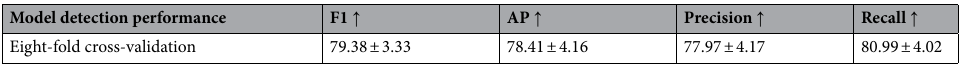
Table 1. DefectTrack ’s standalone detection performance. Average detection performance sets for eight-fold cross-validation and the overall standard deviation across all image sequences are presented here. Note that up arrows indicate that the higher the score the better the model performance. For details of the detection metrics, see Supplementary Sect.